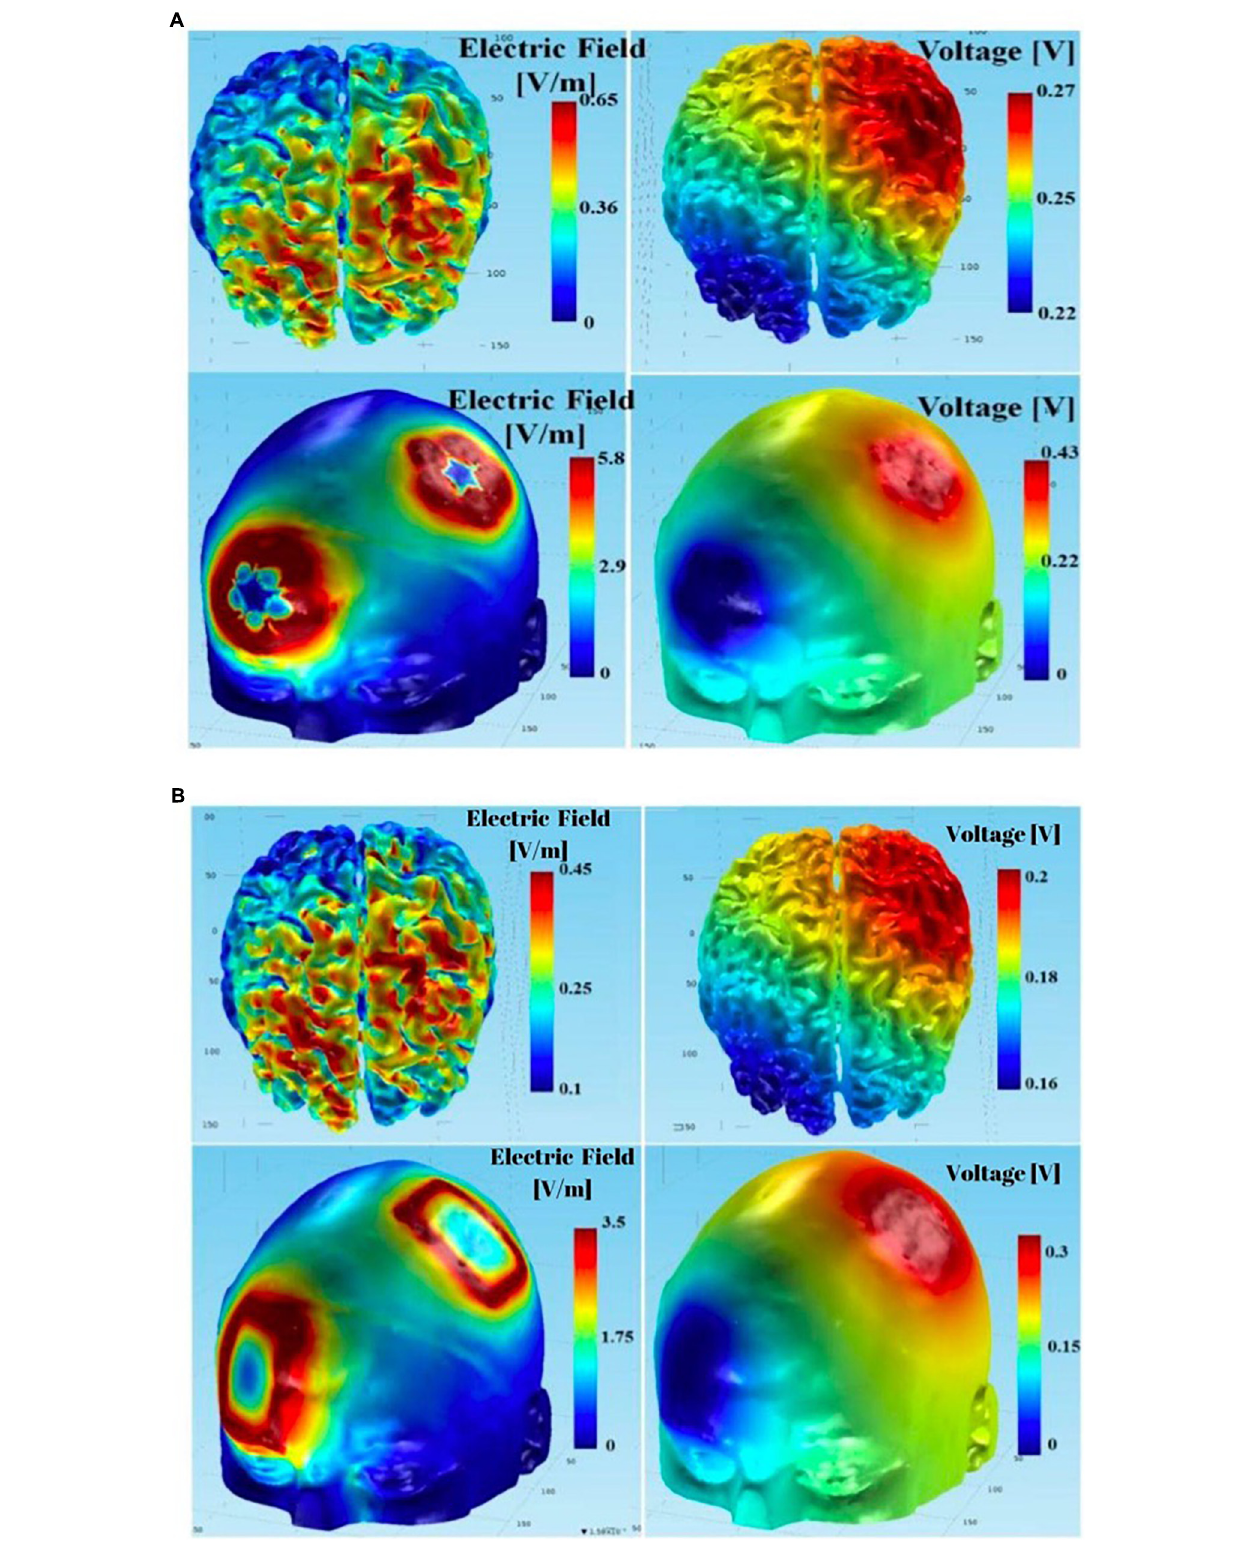
FIGURE 14 | Using the complete model (including CSF in the simulations): (A) results of tDCS with anodal PMC - return at right supraorbital region montage using the circular array electrodes; (B) results of tDCS with anodal PMC - return at right supraorbital region montage using the rectangular sponge electrodes.